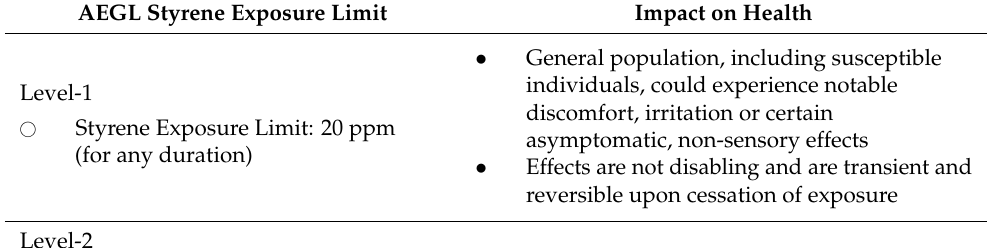
Table 3. Summary of AEGL Styrene Exposure Limits and Health